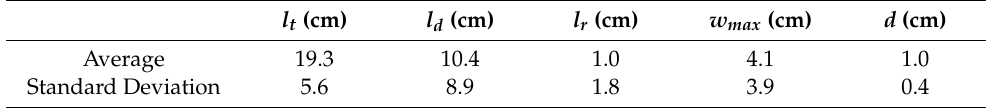
Table 5. Average measurements of scallions.